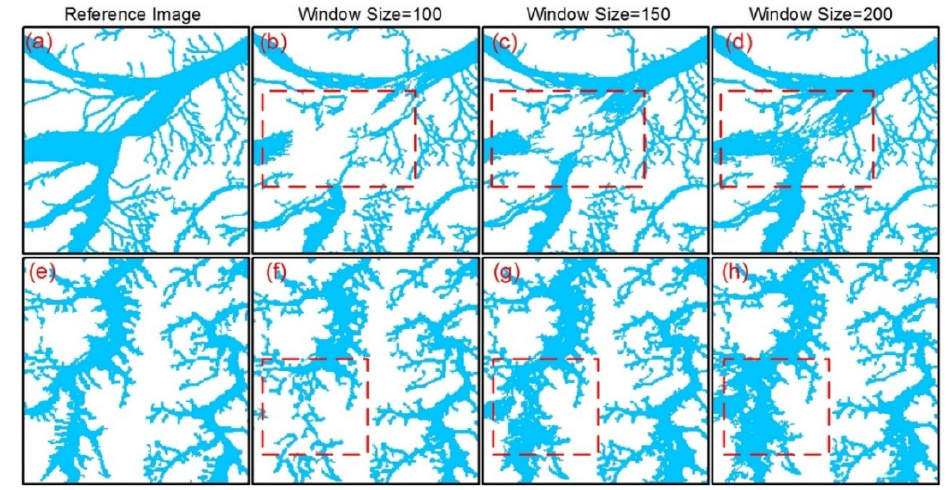
Figure 10. Reference maps and wadi extraction results based on different window sizes. As the window size increases, wide wadis become more and more complete, but commission errors around small wadis become increasingly unacceptable; ( a – d ) different window sizes for block 1; ( e – h ) different window sizes for block 2.